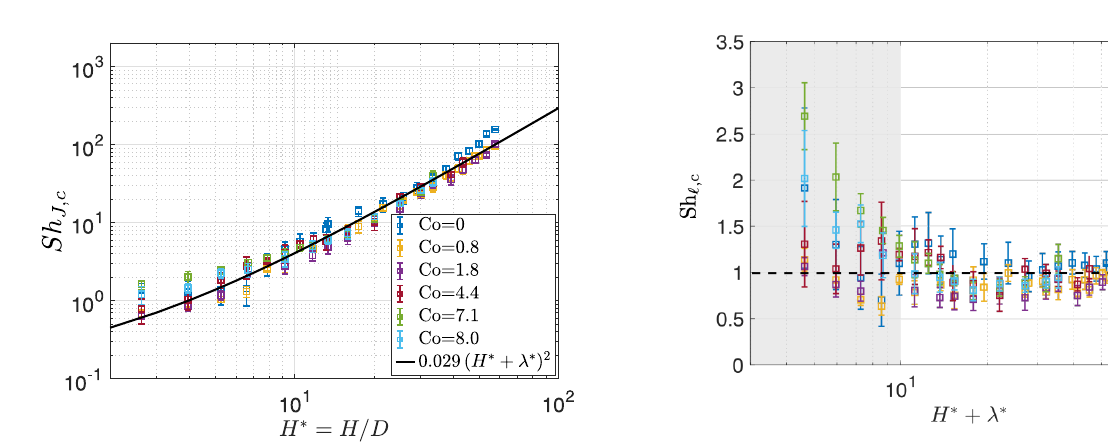
Figure 3. Global cohesive Shields number, Sh J , c , as a function of H ∗ = H / D for the cohesion considered in Fig. 2. The solid line is given by Eq. (9).